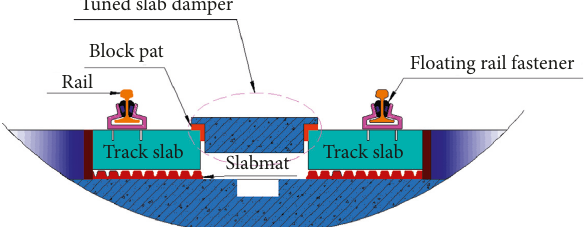
Figure 1: Structure of the fastener/tuned slab damper/floating slab.